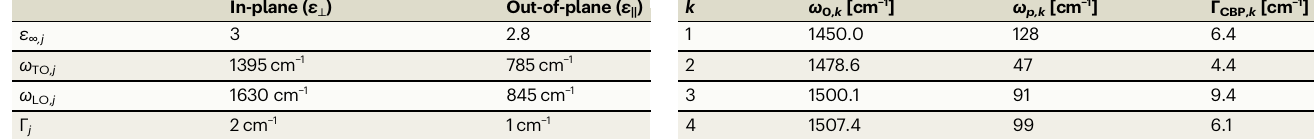
Table 2 | Parameters for calculating the in-plane and out-of- plane permittivity components of h-BN according to Eq. (1) In-plane ( ε ⊥ )